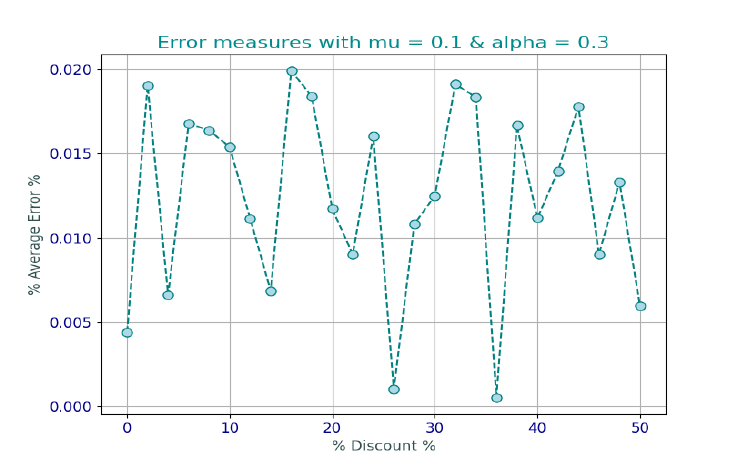
Fig. 2. Measurement error diagram in the discount equation (source: